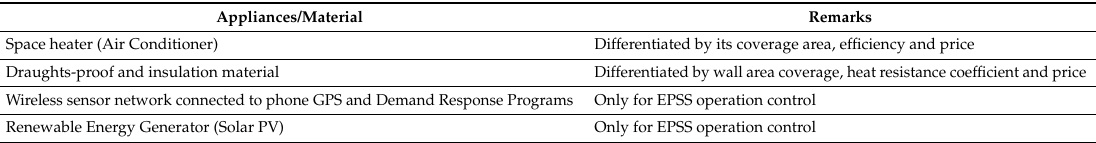
Table 3. List of appliances to deliver space-heating service.